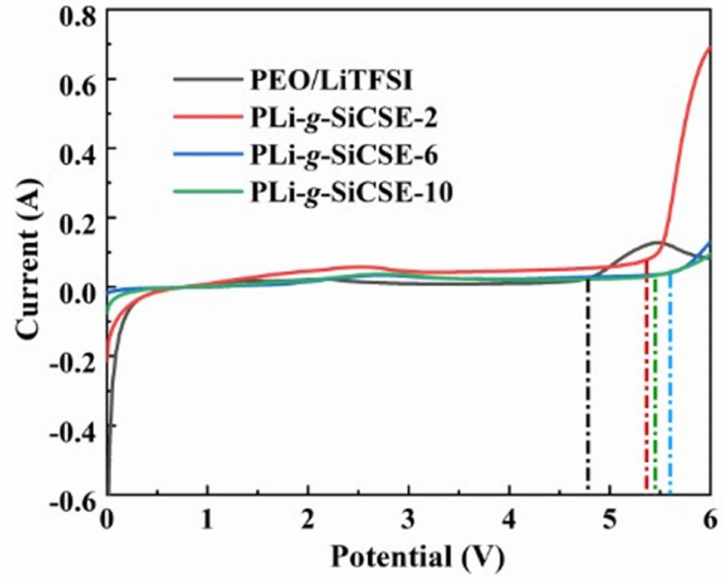
Figure 10. LSV curves of the SS|PLi- g -SiCSE-x|Li cell at 0.1 mV s − 1 . The PLi- g -SiCSEs are sandwiched between two lithium metal electrodes to assemble all-solid-state Li/Li symmetrical batteries. Figure 11a shows the time-dependent plat- ing/stripping profile of the cell with PLi- g -SiCSE-6 as electrolyte over 480 h at a constant current density of 0.2 mA · cm − 2 and at 60 ◦ C. A stable overpotential of 27 mV demonstrate that reversible lithium plating/stripping performance can be achieved in Li|PLi- g -SiCSE- 6|Li cell, and no short circuit is observed. Figure 11b exhibits an enlarged plot of the lithium plating/peeling cycling curves of Li|PLi- g -SiCSE-6|Li symmetric cell at 70–80 h. The overpotential voltage is around 27 mV, indicating its superior interfacial stability with the lithium